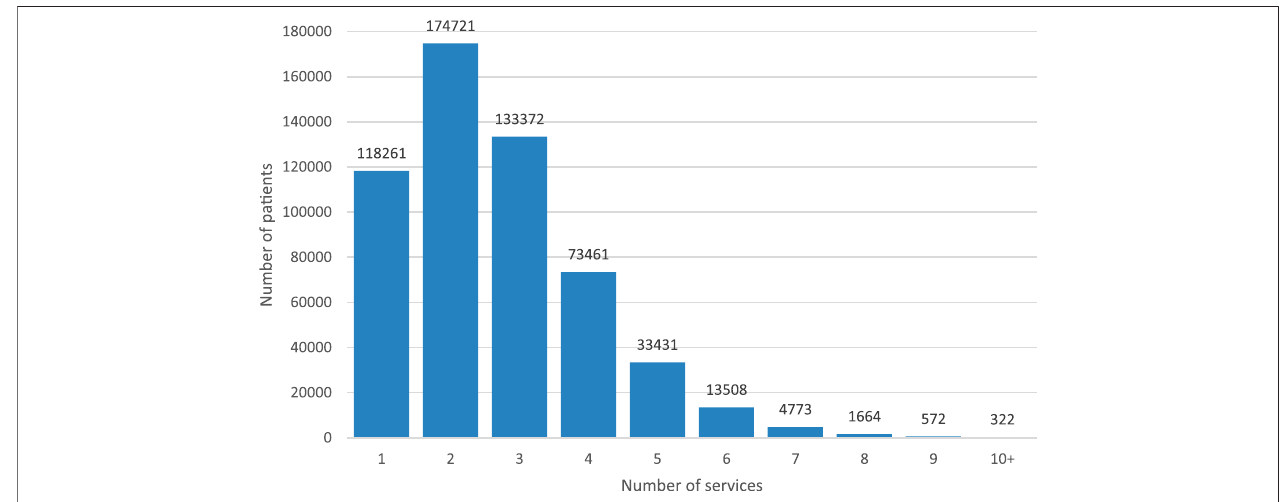
FIGURE 6 | Number of elderly patients on chronic polypharmacy in Poland in 2018 by number of healthcare services in which their prescriptions were issued.